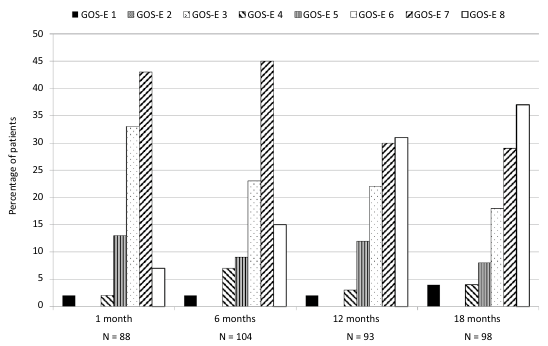
Fig. 1 Outcomes of patients during follow‑up. Proportion of patients in each Glasgow outcome scale extended (GOS‑E) category at 3, 6, 12 and 18 months. Numbers of patients evaluated at each time point are given at the bottom